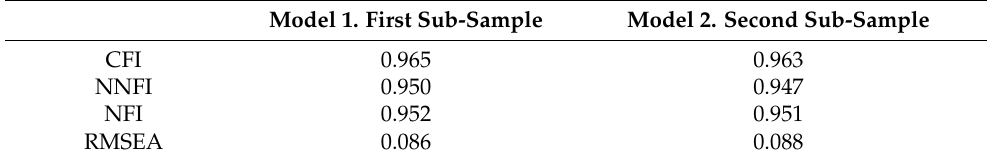
Table 3. Global Table 3. Global measurement.